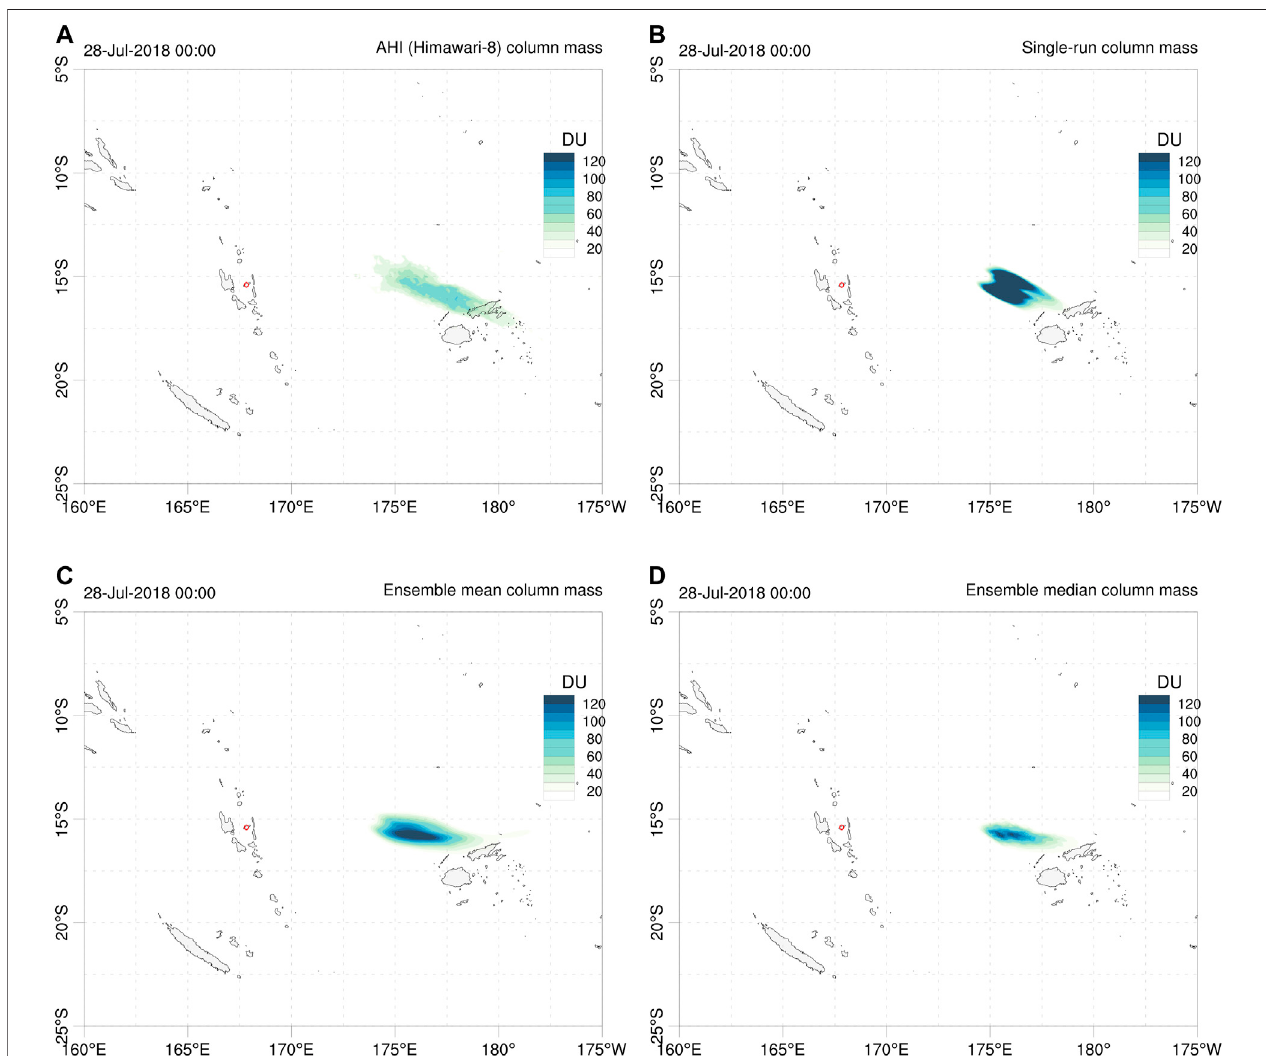
FIGURE 1 | Comparison between: (A) Ambae AHI SO 2 column mass retrievals, (B) single-run (unperturbed central member), (C) ensemble mean deterministic forecast, (D) ensemble median deterministic forecast. All snapshots correspond to July 28, 2018 at 00:00 UTC. Contours in Dobson Units (DU). Red circle shows the location of Ambae